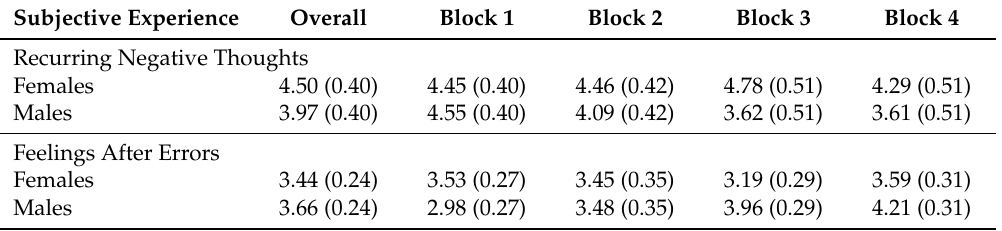
Table 3. Subjective experience. Means are adjusted for BDI-II, Brooding, and Reflection covariates. Subjective